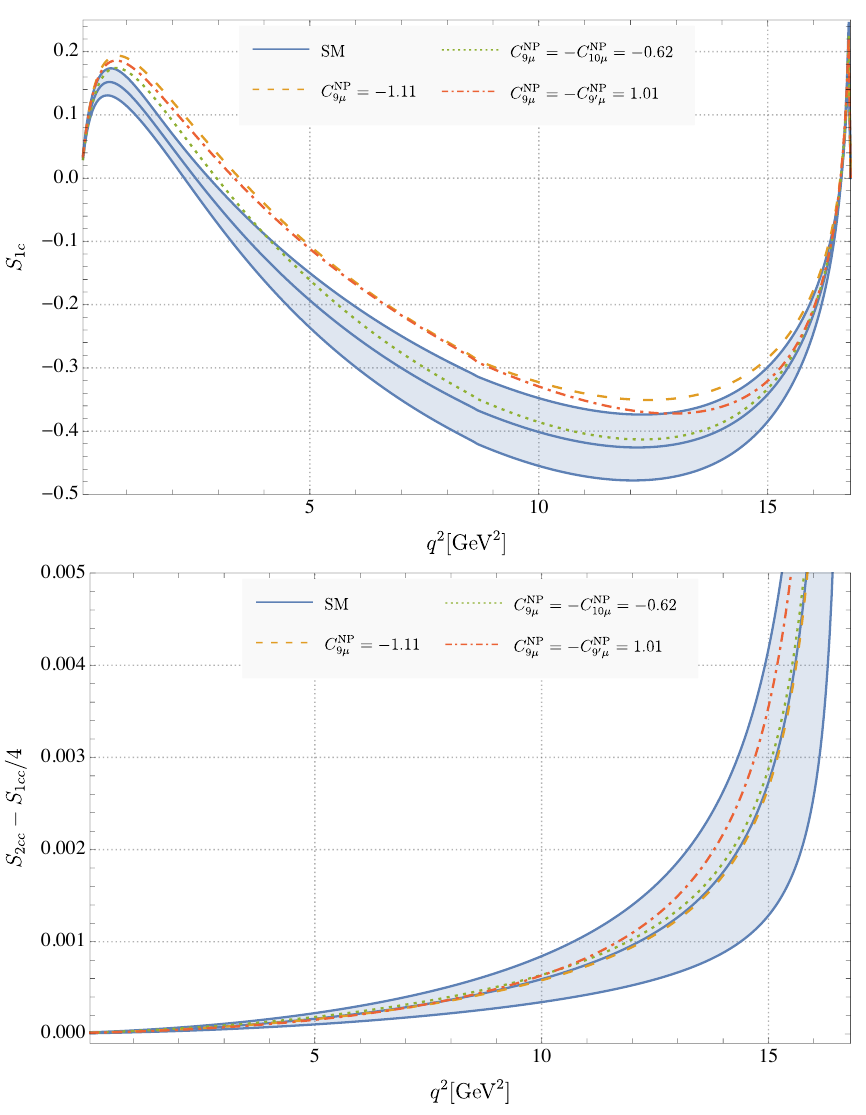
Figure 3 . Variation of S 1 c (top) and S 2 cc (cid:0) S 1 cc = 4 (bottom) with respect to the dilepton invariant mass, in the case of the SM and three NP scenarios.